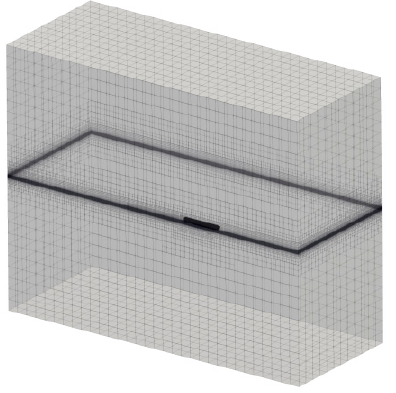
Figure 7. Computational domain of FreSCo+ and 5.7 M mesh used for the resistance and propulsion simulation .